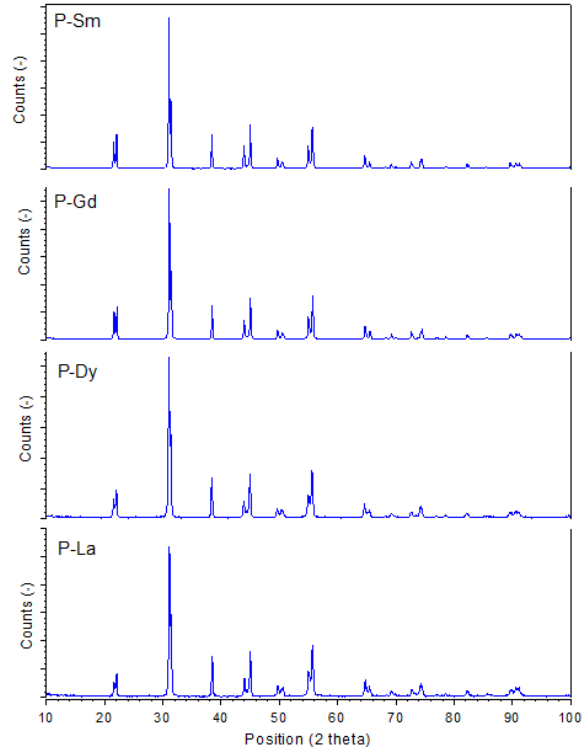
Figure 2. X-ray di ff raction (XRD) pattern measurements of the multicomponent PZT-type Figure 2. X-ray diffraction (XRD) pattern measurements of the multicomponent PZT-type materials.